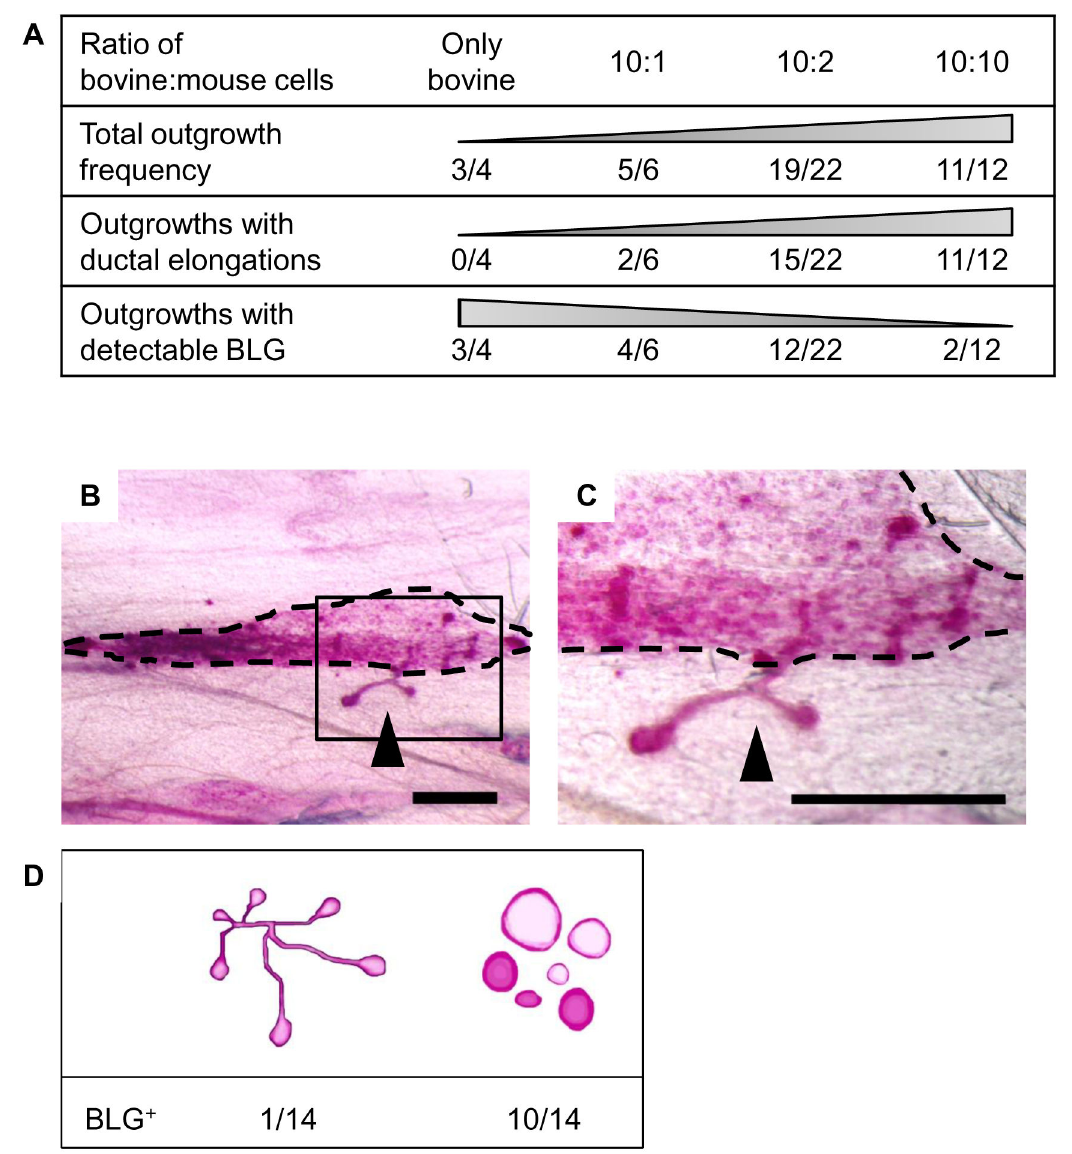
Figure 4. Co-transplantation of mouse and bovine epithelial cells rarely produces a chimeric outgrowth in the mouse. A : Frequency of outgrowths with mouse and bovine characteristics developed in the cleared mouse mammary fat pad. Outgrowths with ductal elongations and outgrowths with detectable DNA levels of the bovine-specific BLG sequences were monitored in fat pads transplanted with a range of bovine-to-mouse cell ratios. B , C : Low and high magnification, respectively, of Carmine-stained outgrowths developed from mouse and bovine MECs, co-transplanted at a ratio of 10:10. Region of spherical outgrowths is outlined in dashed line. Ductal protrusion is marked with arrowhead. Bar = 1 mm. D : Number of BLG-positive outgrowths developed in distinctly spherical and ductal outgrowth regions (n = 14 for each